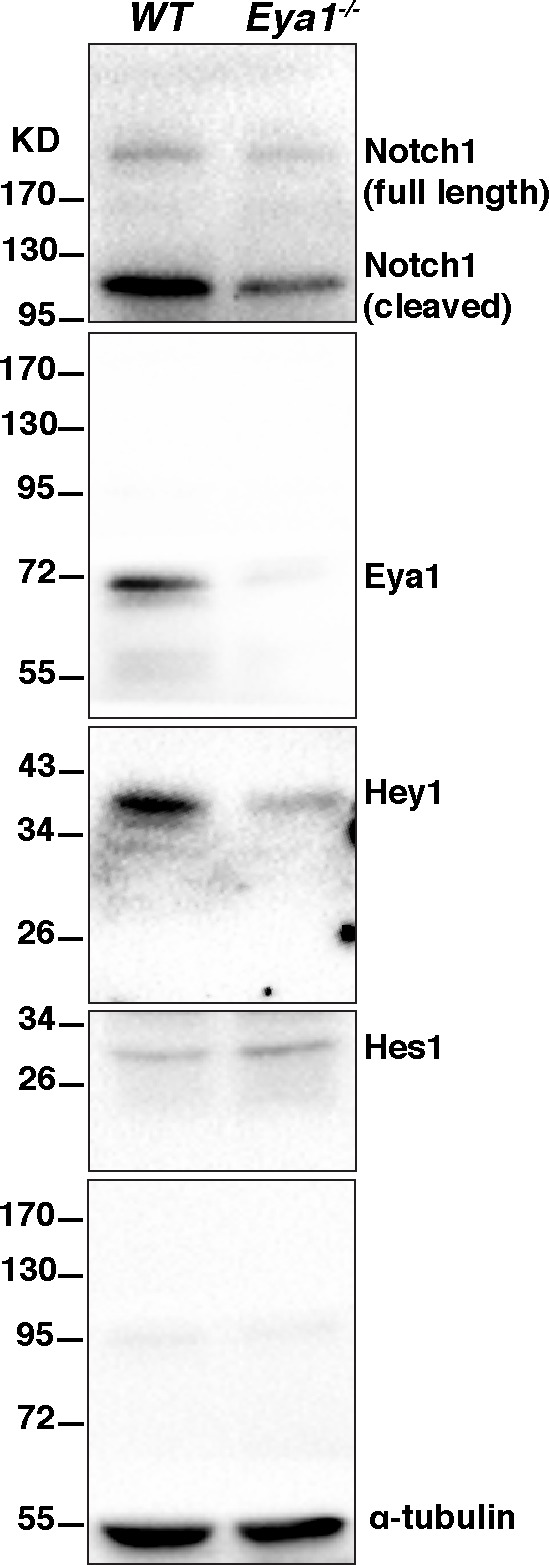
Complete western blots for Figure 4M.